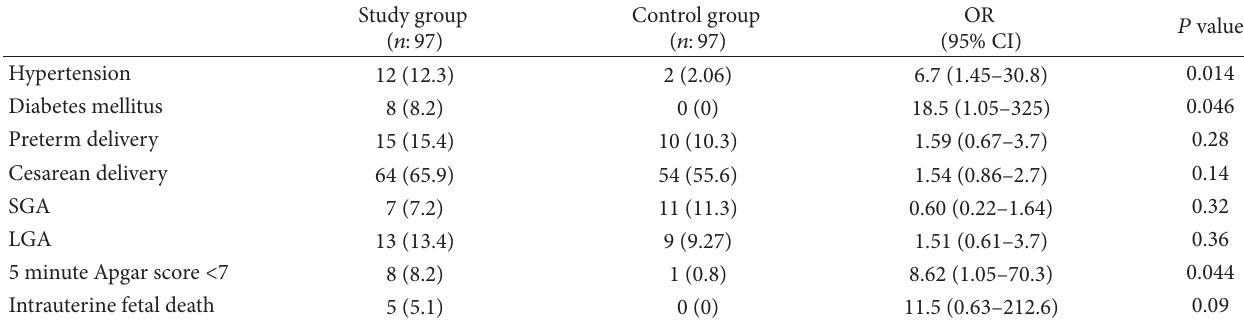
T 5: Comparison of maternal and neonatal complications between women